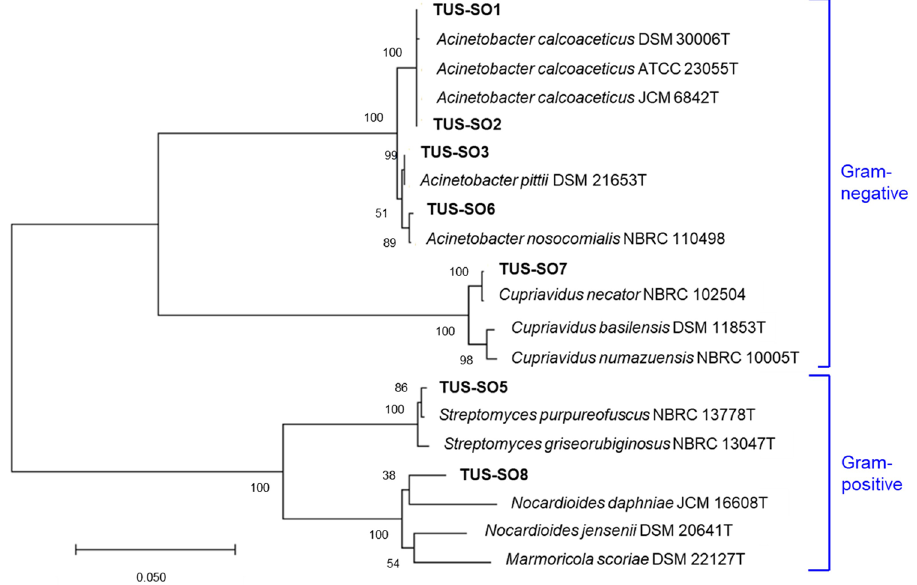
Figure 3. Phylogenetic relationships of 2-PAP–transforming bacteria isolated in this study based on the 16S rRNA gene sequence. Bootstrap values from 1000 replications are shown at each of the branch points on the tree.